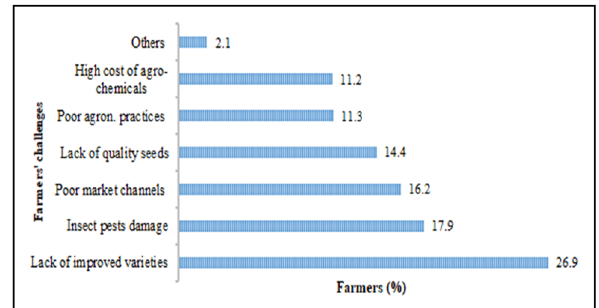
Figure 5: Main challenges perceived by farmers in Lablab production in Tanzania ( χ 2 = 10.079; p = 0.994, df = 24 )